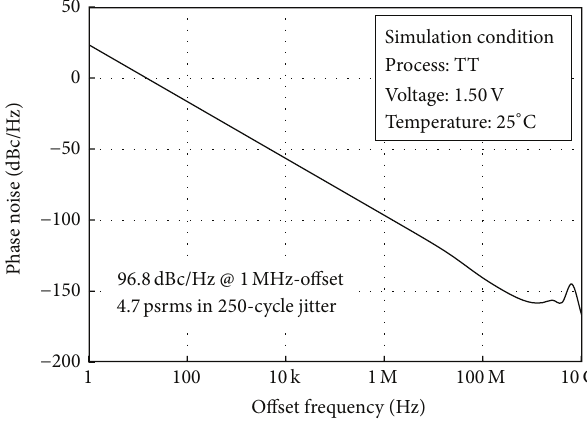
Figure 18: Postlayout simulation result of VCO phase noise charac-